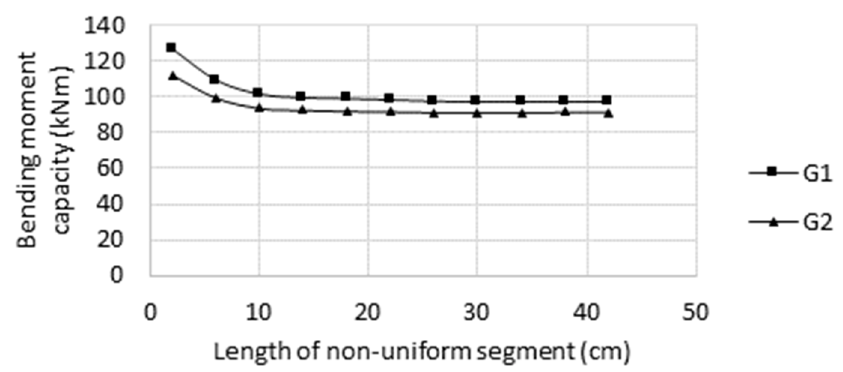
Figure 14. Impact of naturally corroded segment length on the simulation results.